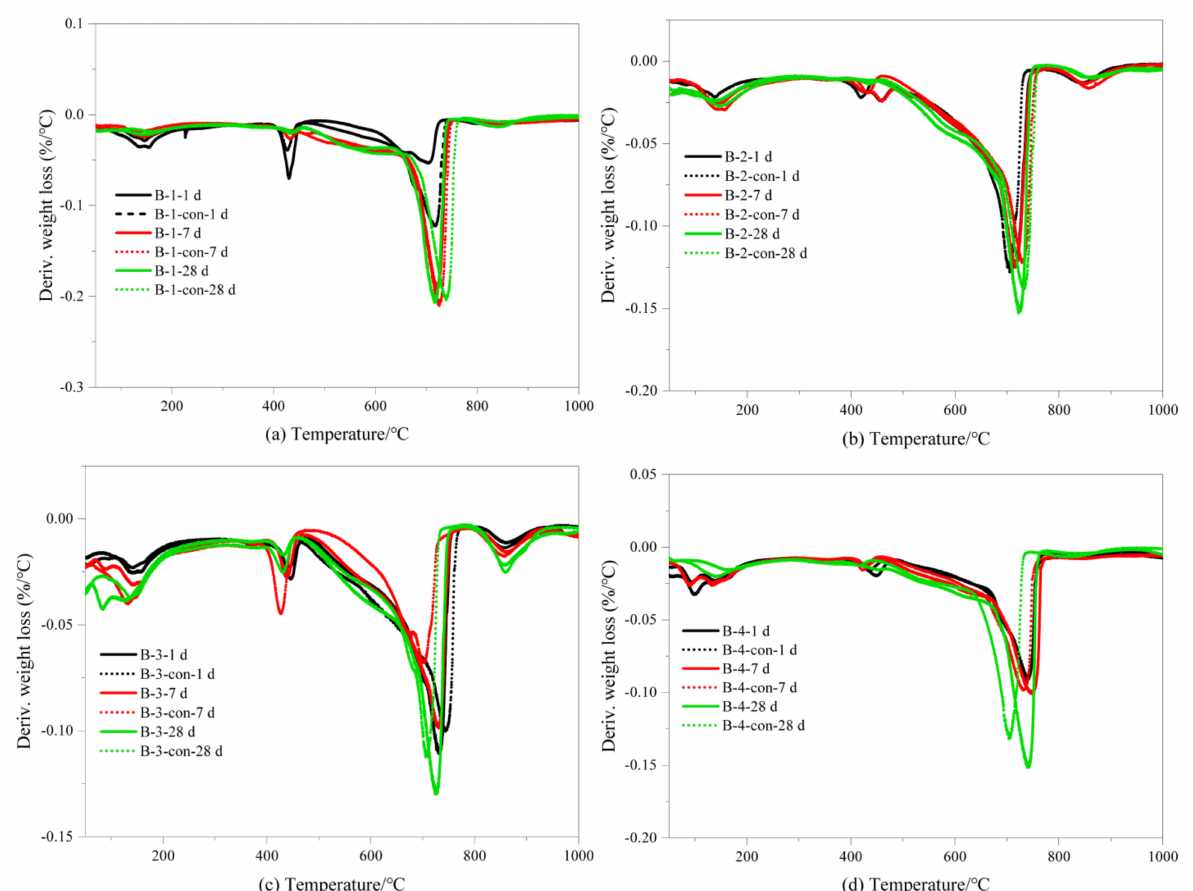
Figure 13. Derivative weight loss of different cement-based composites of B-1 series ( a ), B-2 series ( b ), B-3 series ( c ) and B-4 series ( d ) with different ages by DTG.